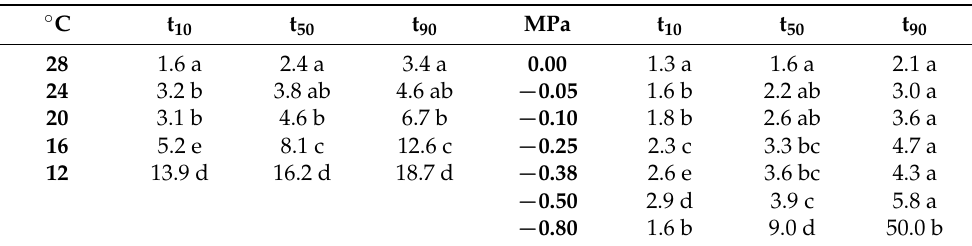
Table 3. Germination dynamics (t 10 , t 50 , and t 90 ) at the different studied temperatures and water potentials at 24 °C.